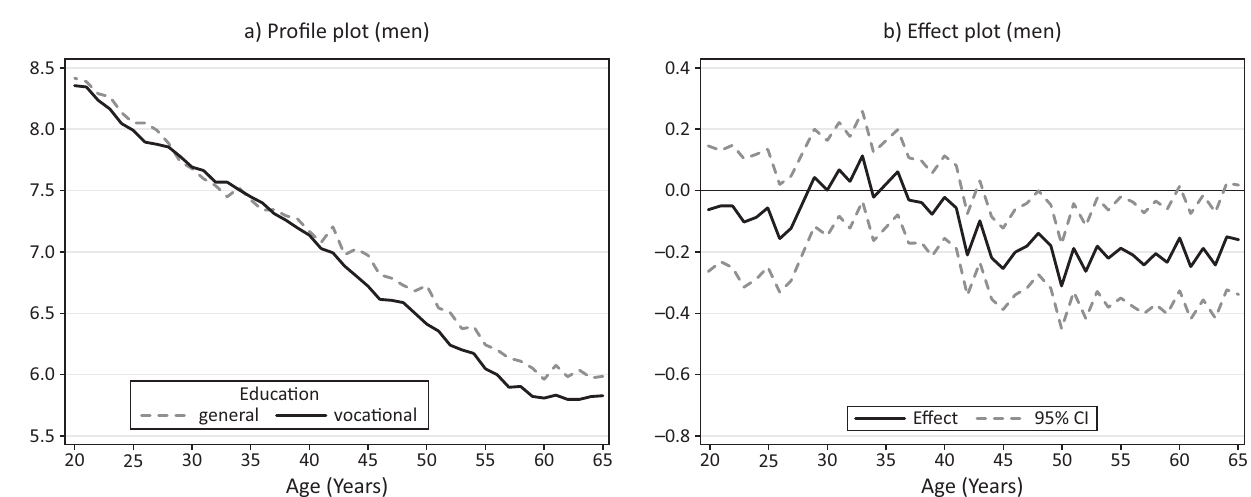
Figure 6. Health satisfaction over the life course: General versus vocational education for men. Note: Conditional profile plots (left) and conditional effect plots (right) estimated by non-parametric models of vocational and general training on health satisfaction. Control variables include period effects, cohort effects, German nationality, parental educational back- ground, residence in West Germany, and educational level. N persons = 20,554; N person-years = 146,548. See Table A9 in the Appendix for detailed regression results. Data source: GSOEP